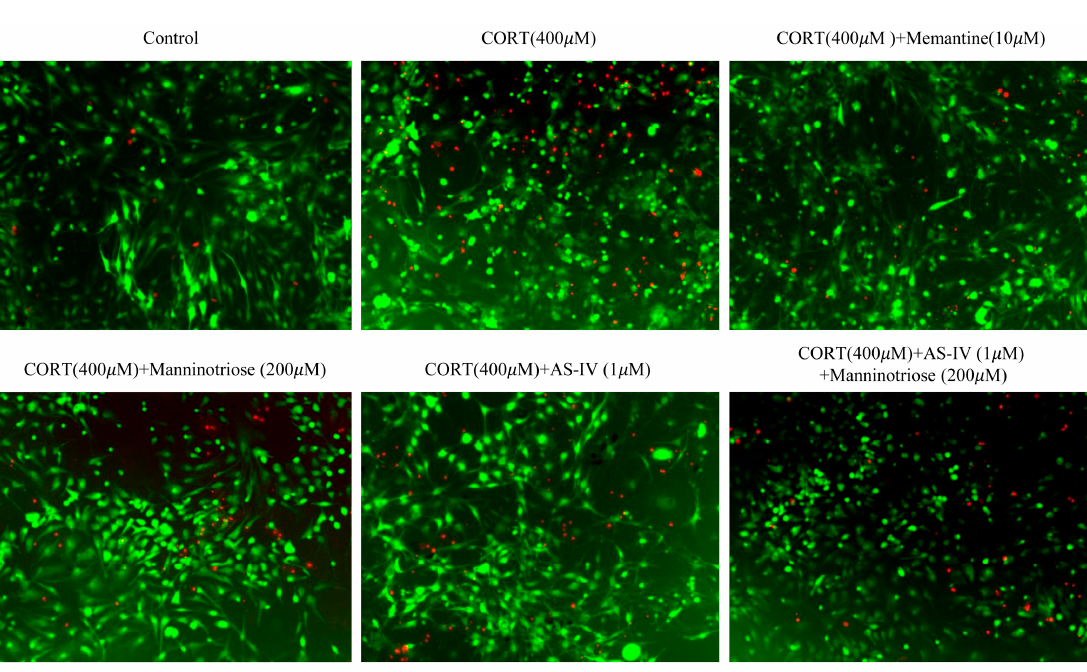
Figure 2. Effect of Manninotriose and AS-IV on cell survival in CORT injured hippocampal neurons as determined by FDA/PI staining. FDA (green) is taken into the living cells while PI (red) stains dead cells.